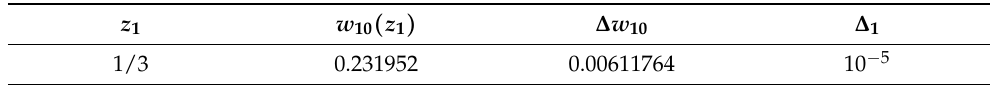
Table 1. Numerical characteristics of example 1.